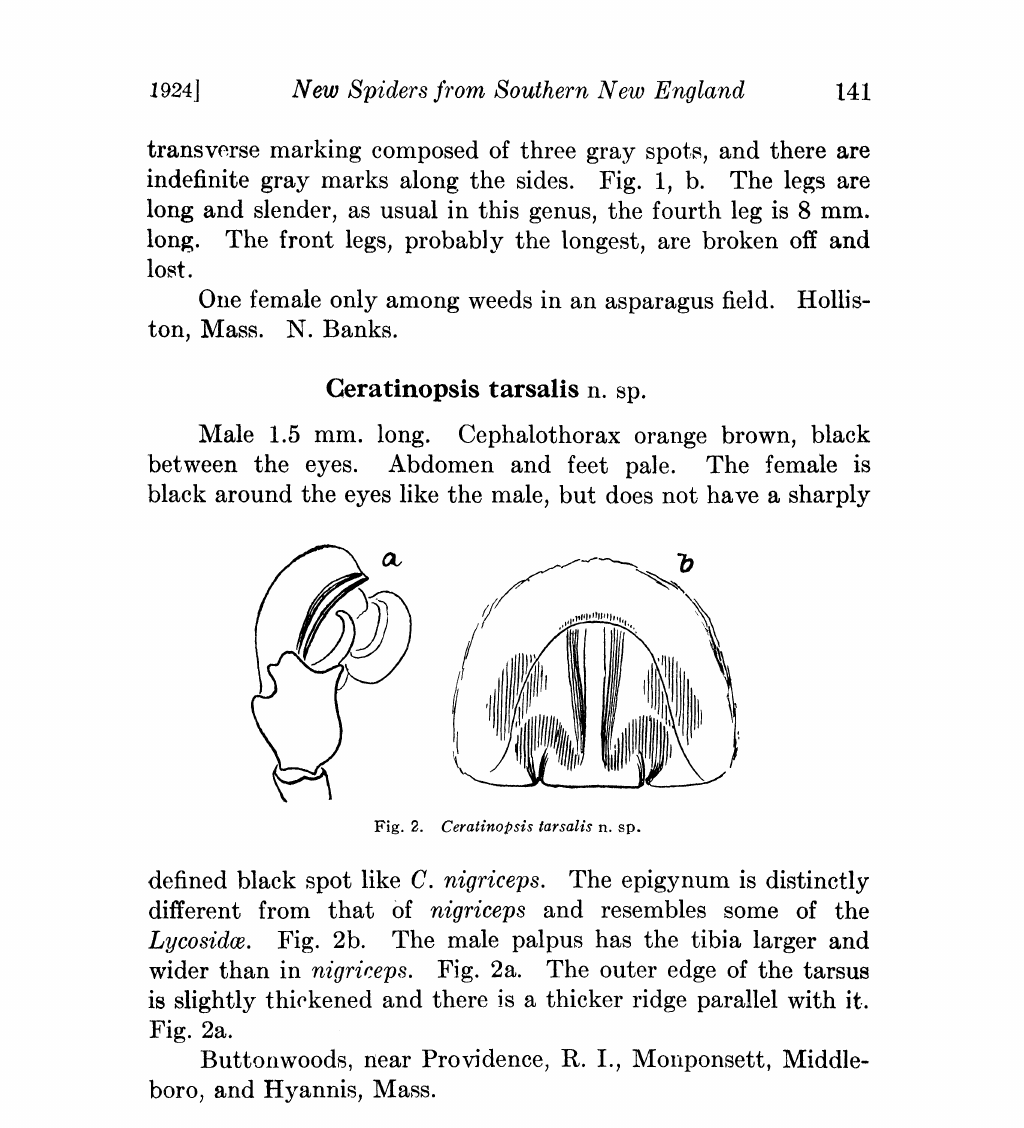
Fig. 2b. The male palpus has the tibia larger and Fig. 2a. The outer edge of the